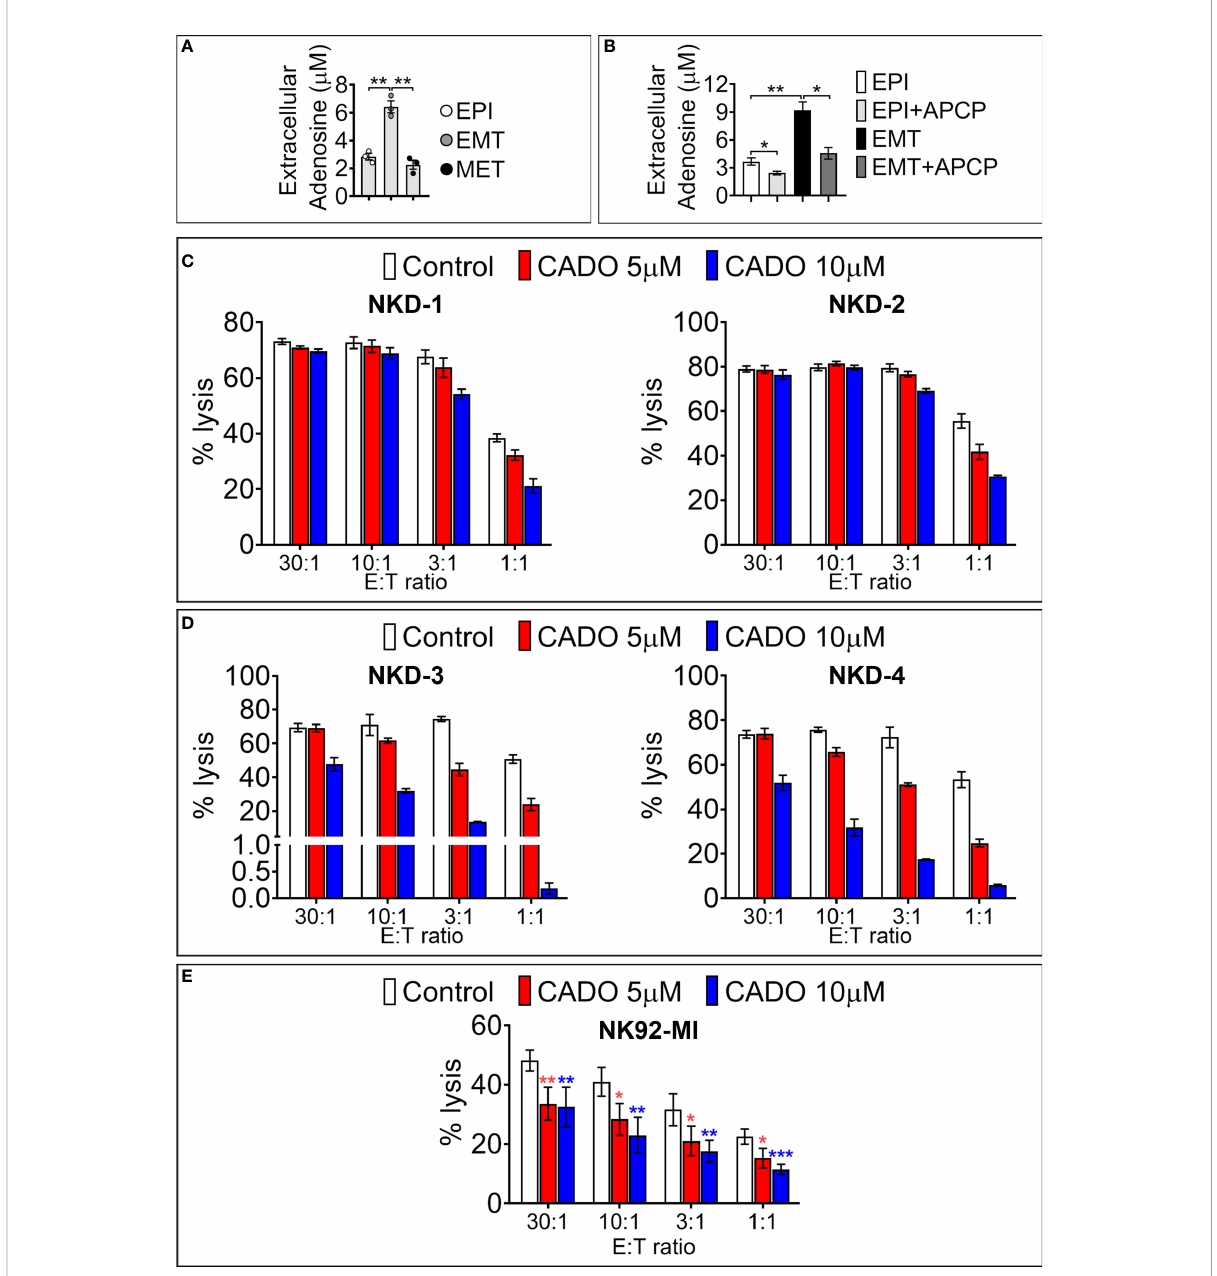
FIGURE 4 SNAI1-mediated CD73 upregulation results in increased extracellular ADO production. (A) Concentration of extracellular ADO released in the culture medium of MDA-MB-468-iSNAI1 cells cultured under control conditions (EPI), after 5 days of Dox (EMT), and after Dox removal (MET). Bars represent means from three independent experiments ± SEM (* P < 0.05, ** P < 0.01 calculated by unpaired t-test). (B) Concentration of extracellular ADO released in the culture medium of MDA-MB-468-iSNAI1 cells cultured under control conditions (EPI) and after 5 days of Dox (EMT) in the absence or presence (+APCP) of APCP (100 µM). Bars represent means from three independent experiments ± SEM (* P < 0.05, ** P < 0.01 calculated by unpaired t-test). (C) NK cells from four healthy donors (NKD-1 to 4) were pre-treated with CADO at 5 µM or 10 µM during 4 days (NKD-1 and NKD-2) or 6 days (NKD-3 and NKD-4). NK cytotoxic activity against K562 cells was measured at the indicated E:T ratios. Bars represent the mean percentage of lysis ± SD. (D) Cytotoxic activity of NK92-MI cells pre-treated for 6 days with CADO at 5 µM or 10 µM against K562 cells at the indicated E: T ratios. Bars represent mean percentage of lysis from three independent experiments ± SD (* P < 0.05, ** P < 0.01, *** P < 0.001 calculated by unpaired t-test). Only one experiment was performed for each NK healthy donor reported in panels (C, D) . Experiments were performed either in duplicates or